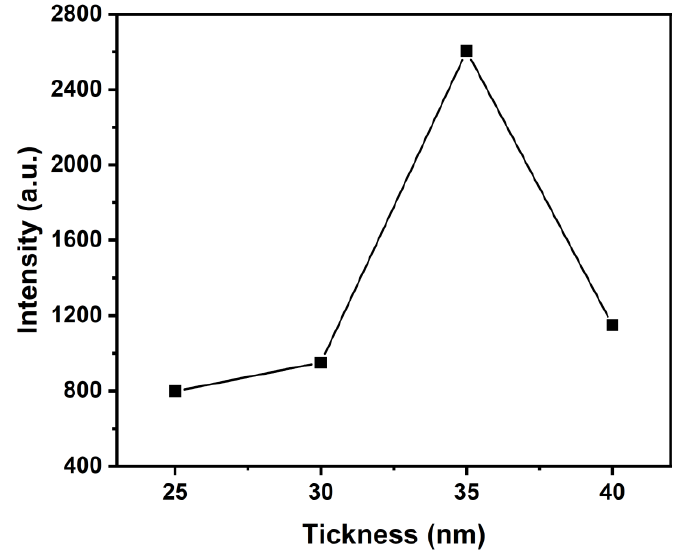
Figure 5. The relationship between Ag thickness and SERS intensity, measured with R6G molecules (10 −4 M).